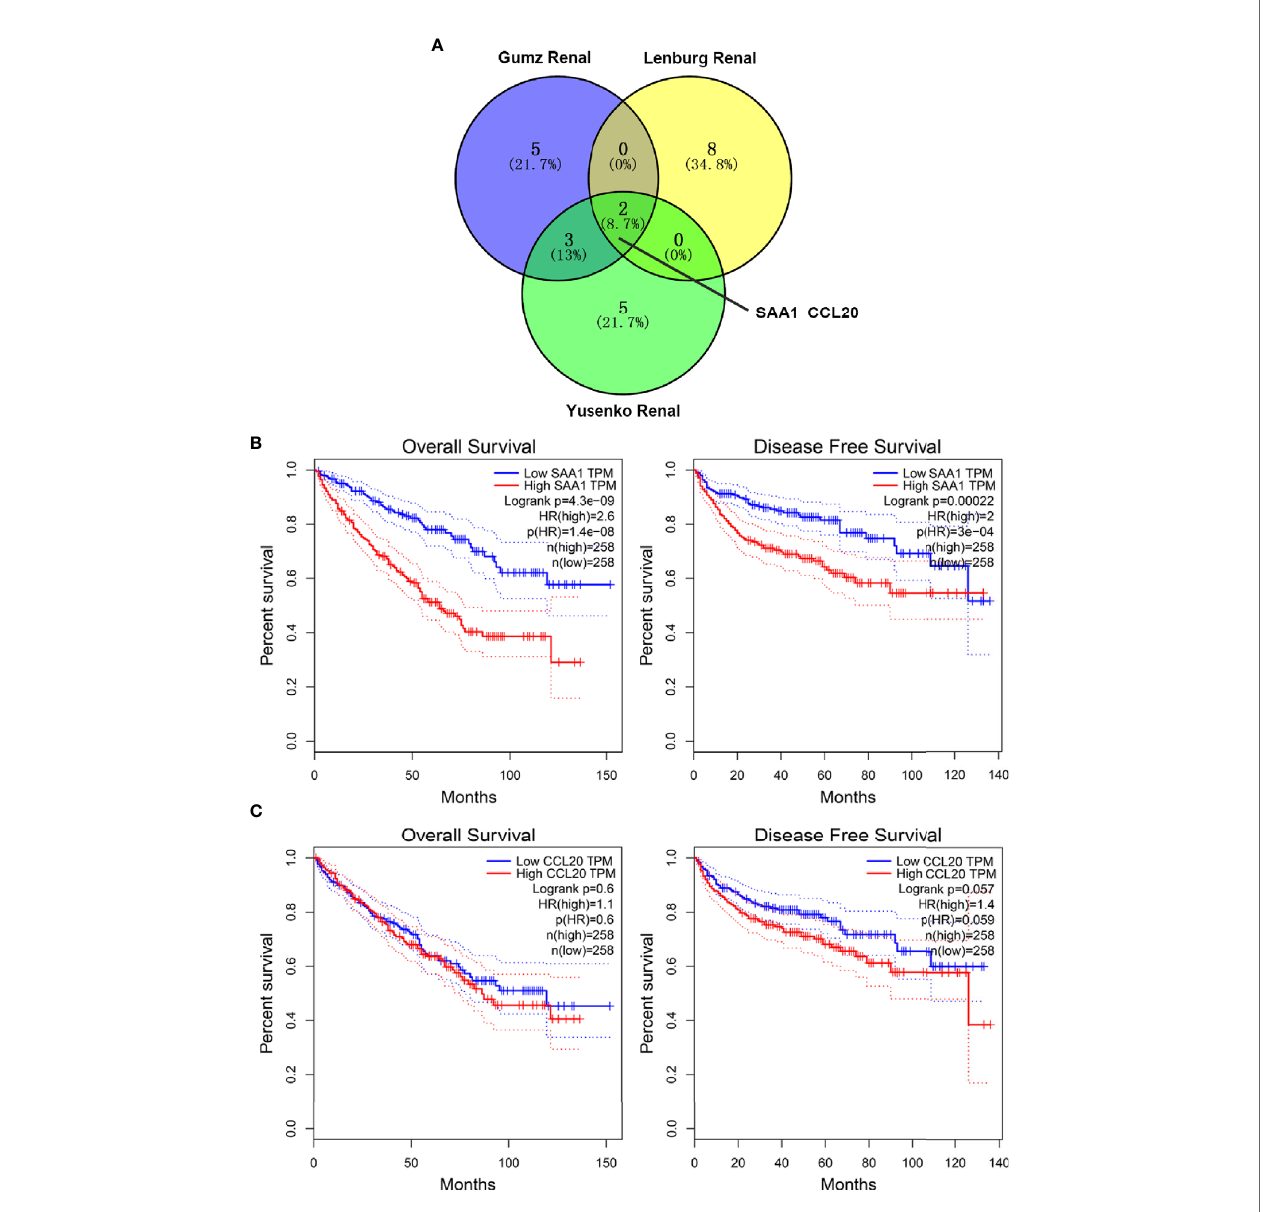
FIGURE 1 | Screening and prognostic analysis of up-regulated target genes in ccRCC patients. (A) Wayne diagram showing top ten up-regulated genes in three public databases. (B) Kaplan Meier curve analysis for the effect of SAA1 expression on the prognosis of ccRCC patients. (C) Kaplan Meier curve analysis for the effect of CCL20 expression on the prognosis of ccRCC